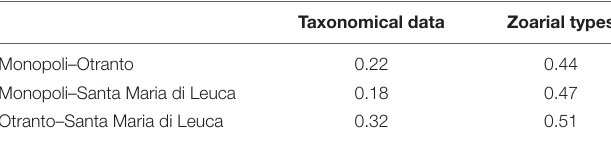
TABLE 3 | Pairwise similarity calculated using Sörensen index based on the presence/absence of taxonomical data and zoarial types data for each pair of